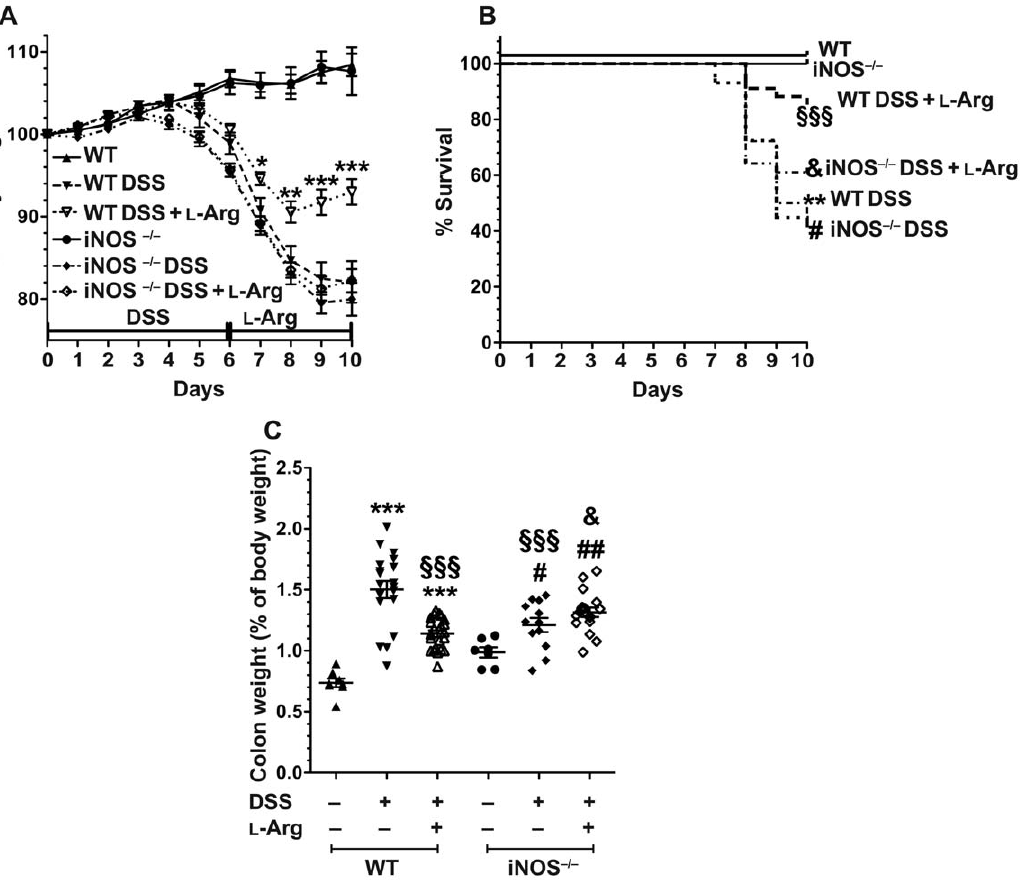
Figure 10. Benefits of L-Arg supplementation in DSS-induced colitis are lost in iNOS 2 / 2 mice. 7-week-old WT or iNOS 2 / 2 C57BL/6 mice received 4% DSS 6 1% L-Arg in the drinking water as in Figures 3–9. (A) Body weights of the mice were measured daily and are presented as a percentage of their initial body weight. * p , 0.05, ** p , 0.01, *** p , 0.001 vs. WT DSS. (B) Survival analysis, as in Figure 3. ** p , 0.01 vs. WT Ctrl; 111 p , 0.001 vs. WT DSS; # p , 0.05 vs. iNOS 2 / 2 Ctrl; & p , 0.05 vs. WT DSS L-Arg. (C) At sacrifice on day 10, colon weight as a percentage of the total body weight was determined as in Figure 3. *** p , 0.001 vs. WT Ctrl; 111 p , 0.001 vs. WT DSS; # p , 0.05, ## p , 0.001 vs. iNOS 2 / 2 Ctrl; & p , 0.05 vs. WT DSS + L-Arg. In (A–C), n =7–8 for controls, n =12–22 for treatments. doi:10.1371/journal.pone.0033546.g010 PLoS ONE |